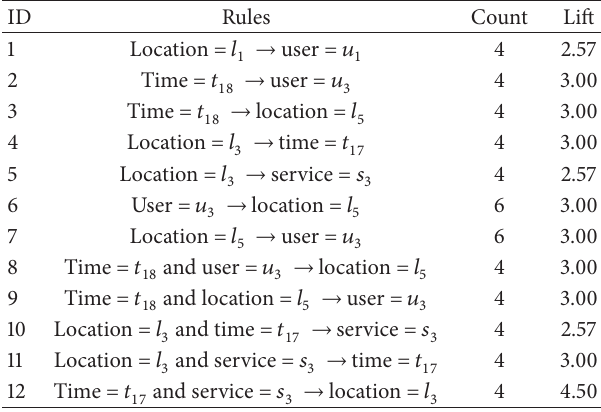
Table 10: The results based on Predictive-Apriori